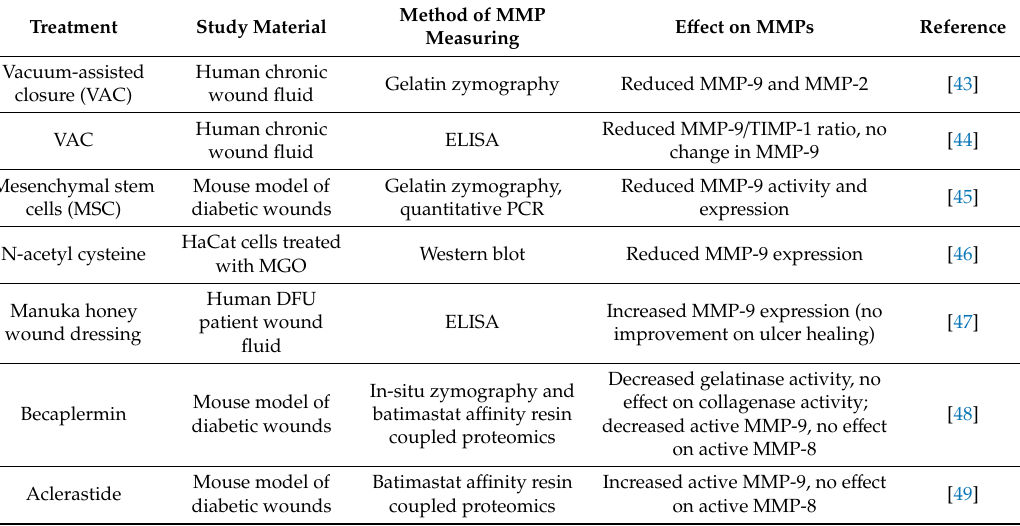
Table 1. Summary of the reported e ff ects on treatments on MMPs and how the MMPs were measured.